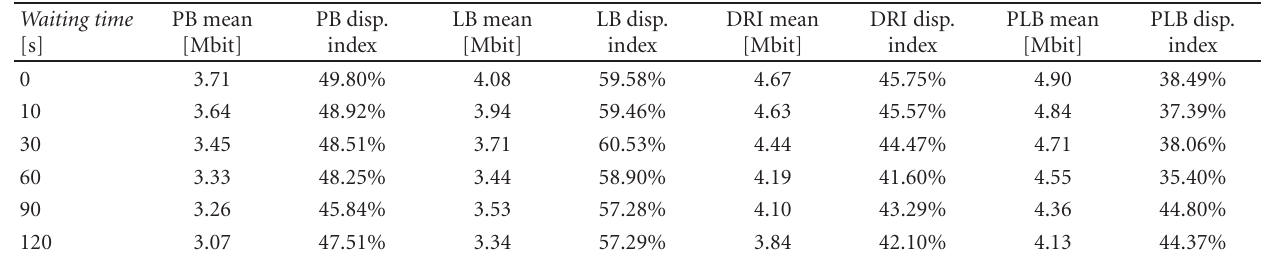
Table 3: Statistics for the CRBs for PB, LB, DRI-VHO, and PLB-VHO